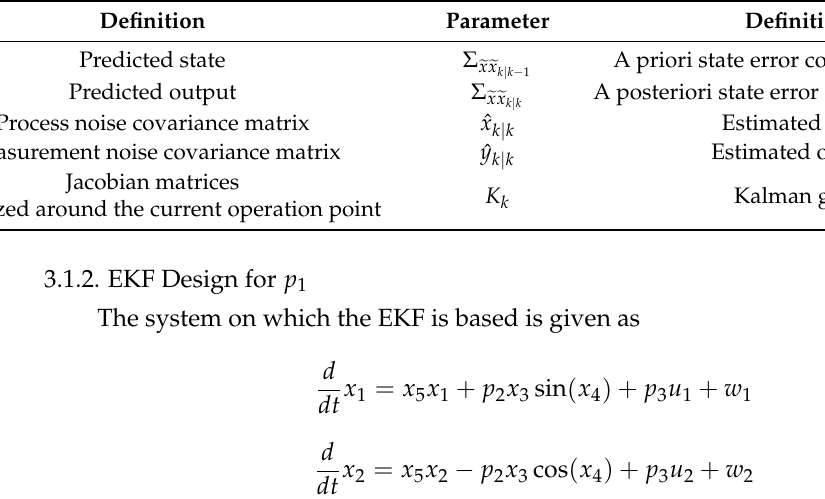
Table 3. EKF-related terms and definitions